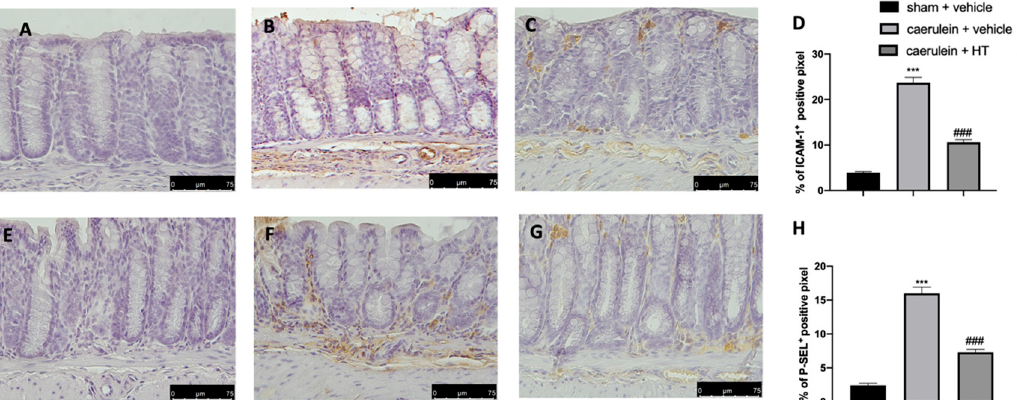
Figure 7. Hydroxytyrosol (HT) effect on intercellular adhesion molecule-1 (ICAM-1) and P-selectin expression: immunohistochemical analysis of ICAM-1 of sham + vehicle ( A ), caerulein + vehicle ( B